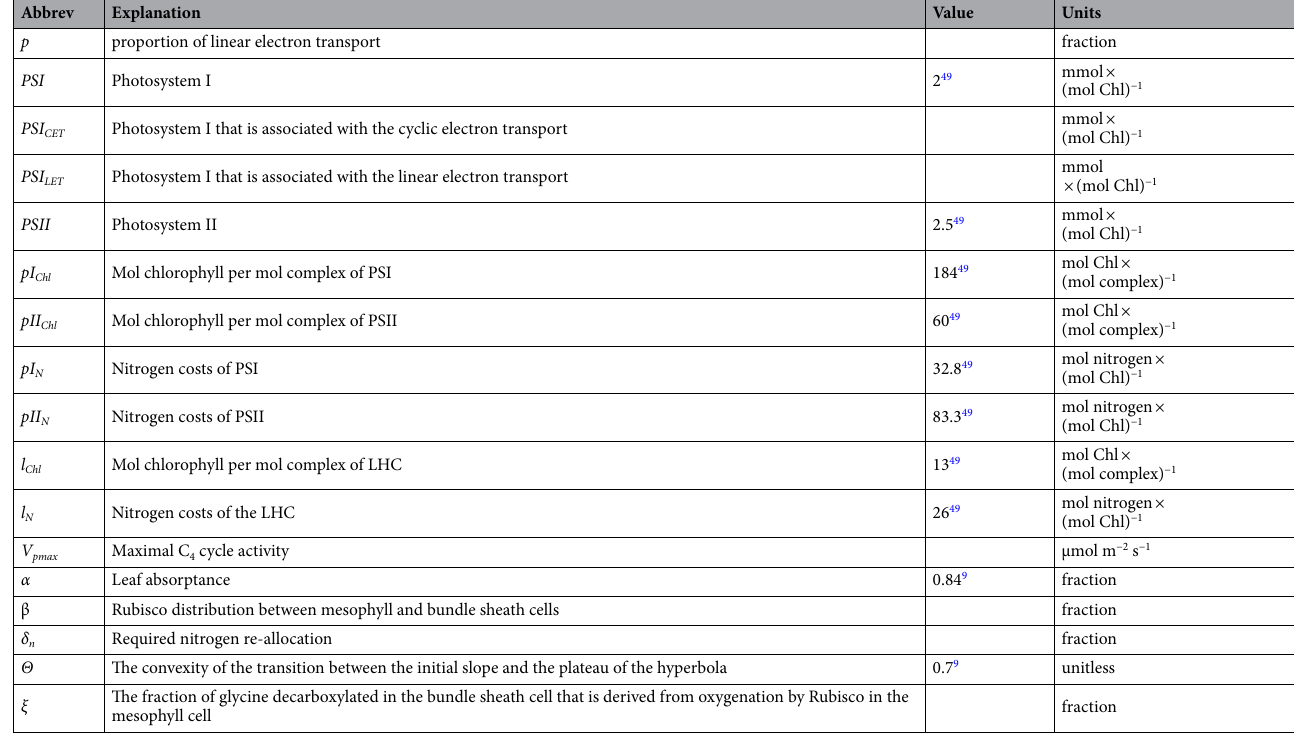
Table 1. A list of all parameters used in the mathematical model. For each parameter, we list abbreviation (abbrev.), explanation, default value (if this exists, with reference) and